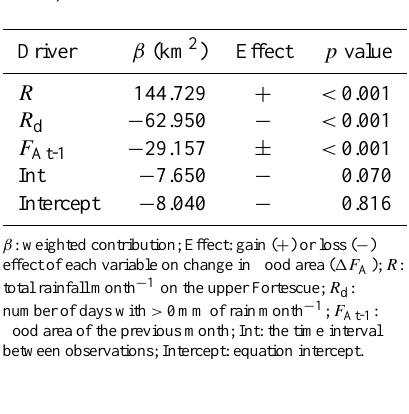
Table 1. Model parameter estimates and standardised statistics for the final linear model to reconstruct historical flood area on the Fortescue Marsh, NW Australia.